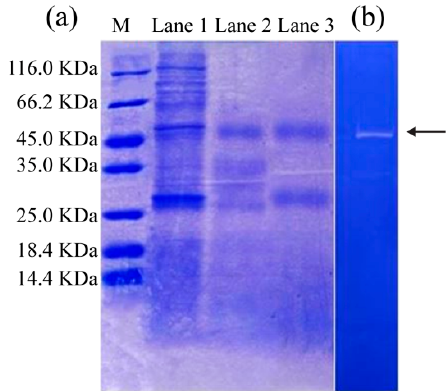
Figure 3. SDS-PAGE of ( a ) SVCE and isolated extracts derived from ISP at pH 3.0 and filtration by 8 KDa ultra-membrane. M: molecular standard marker; Lane 1-SVCE, extracted at initial pH 5.64; Lane 2-SVCE3, obtained at pH 3.0 using ISP; Lane 3- SVCE3(f), produced by filtration of SVCE3 through a membrane with 8 KDa cutoff. ( b ) Casein zymography of SVCE3(f).